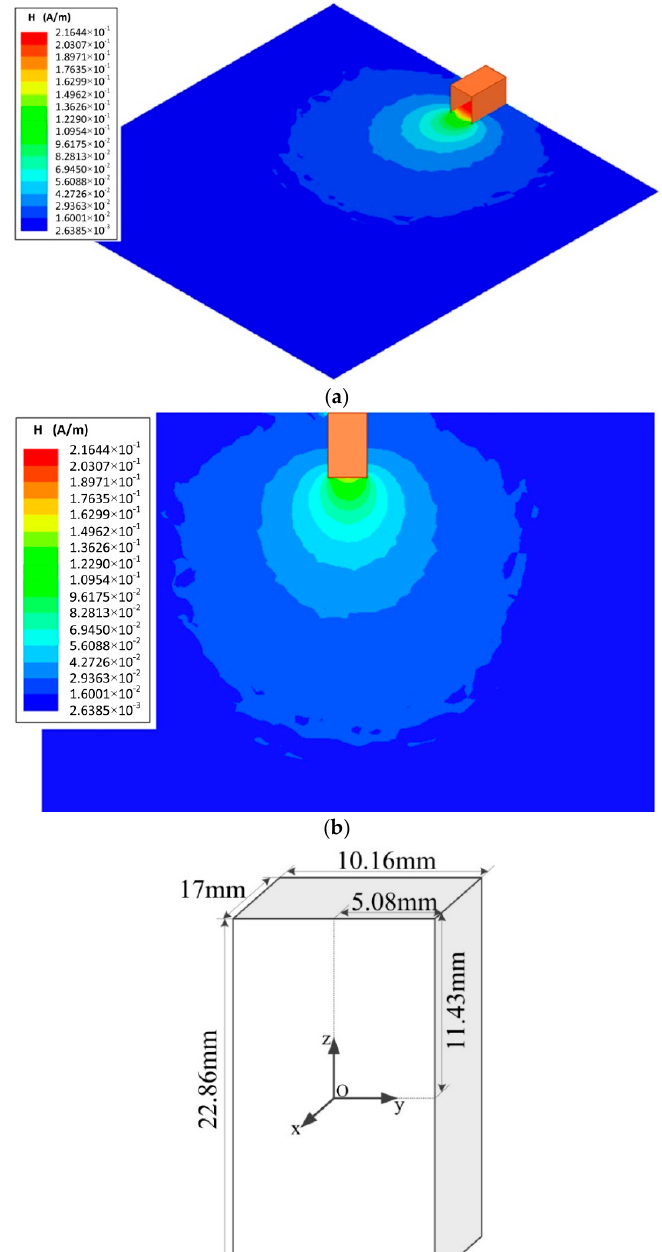
Figure 5. Simulation result of distribution of microwave magnetic field strength. ( a ) Three-dimensional diagram of magnetic field distribution. ( b ) Two-dimensional diagram of magnetic field distribution. ( c ) Three-dimensional diagram of the open-ended waveguide. Observation plane of the simulated distribution of microwave magnetic field strength was in the x-y plane. The size of the observation plane was 160 mm × 160 mm. A open-ended waveguide was placed at the upside. Electromagnetic waves were radiated to the down at 9.19 GHz. The dimensions of the open-ended waveguide were 22.86 mm × 10.16 mm × 17 mm.